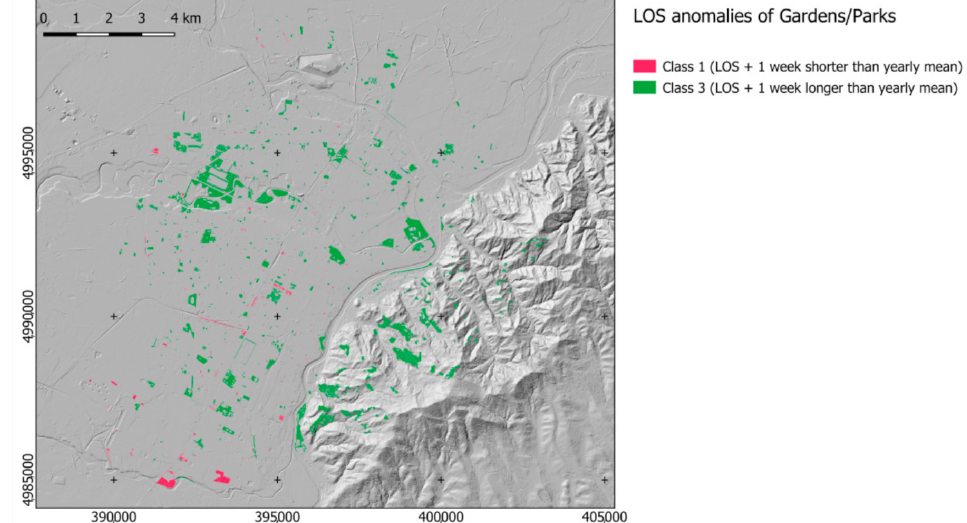
Figure 6. LOS stable anomalies (green = positive, magenta = negative) of the sole urban green class (garden and